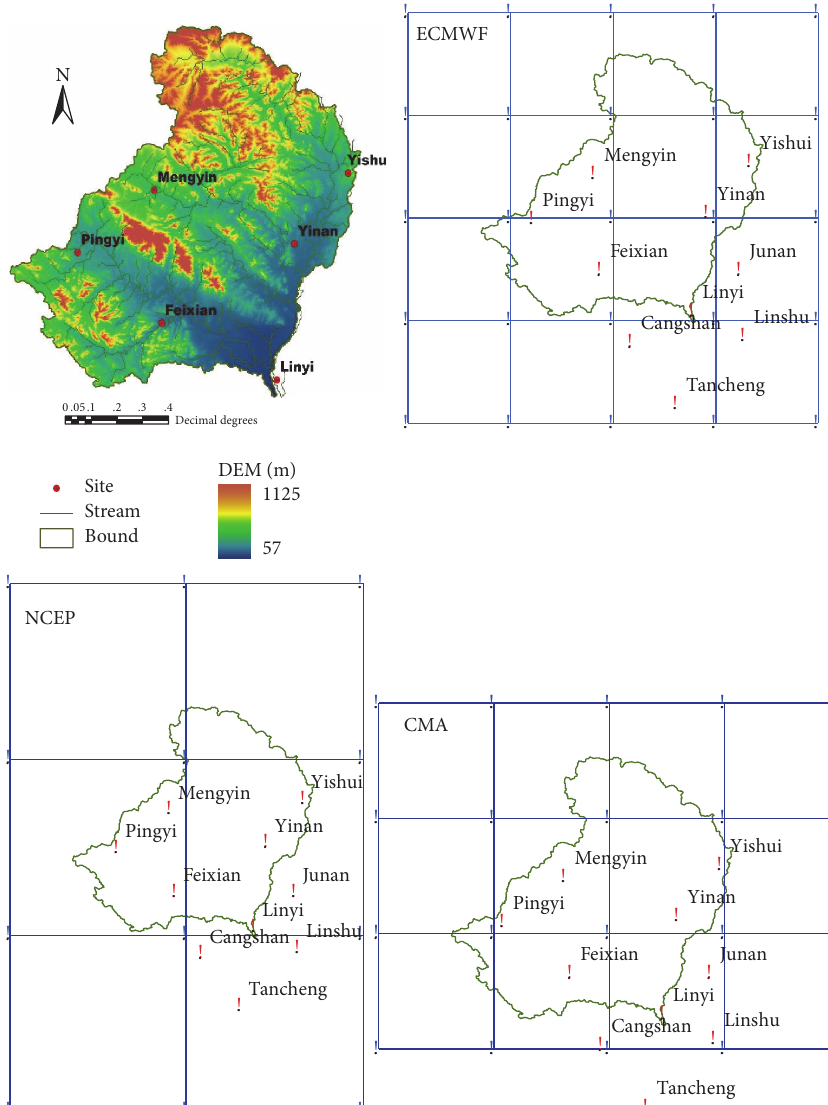
Figure 1: Distribution of stations, catchments, and the selected grid points in ECMWF, NCEP, and CMA ensemble